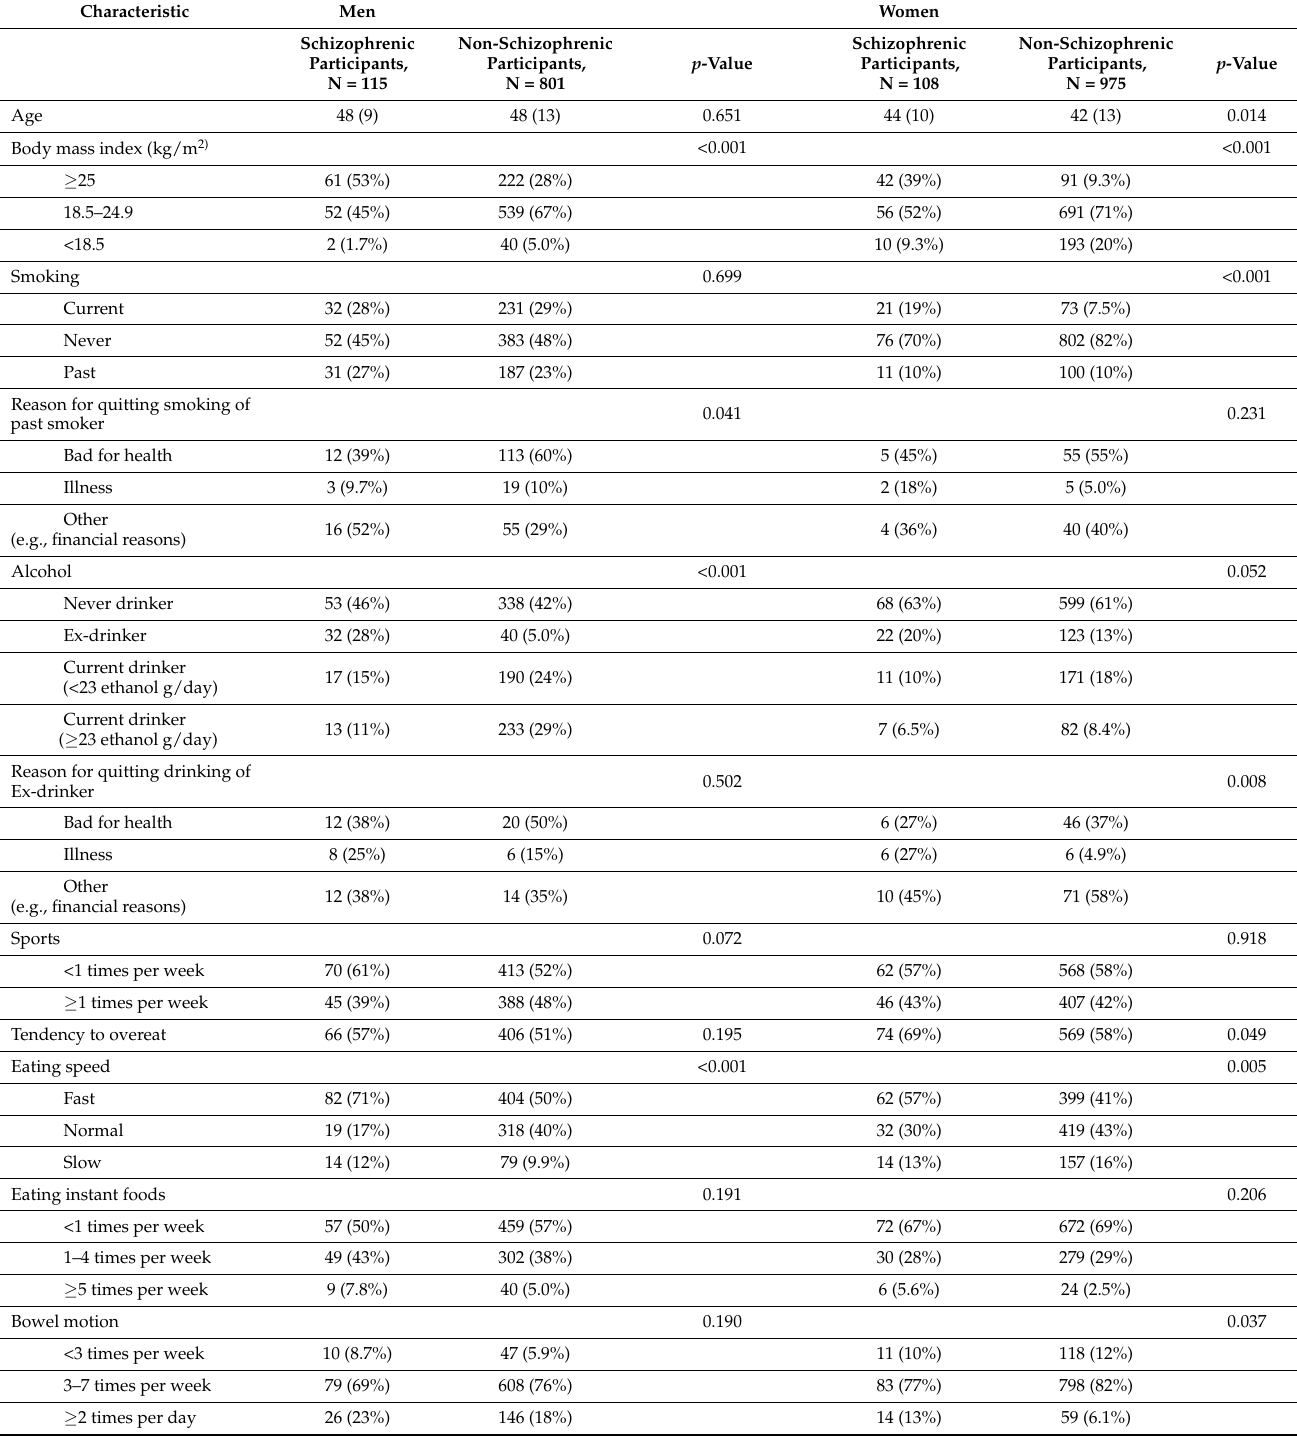
Table 1. Demographic and health-related backgrounds of participants with schizophrenia and participants without schizophrenia according to